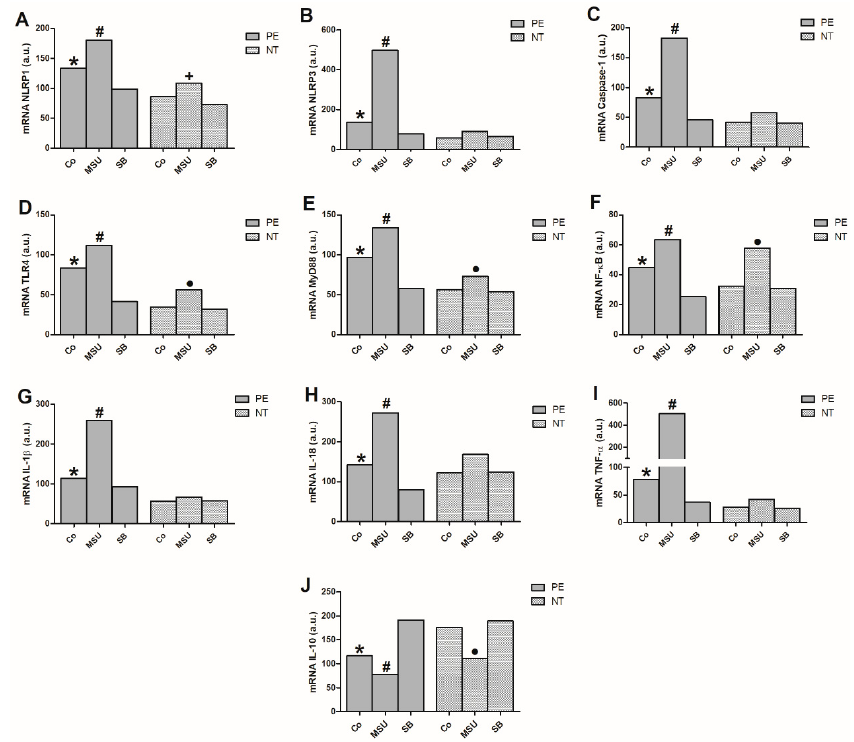
Figure 1. Gene expression of NLRP1 ( A ), NLRP3 ( B ), Caspase-1 ( C ), TLR4 ( D ), MyD88 ( E ), NF- κ B ( F ), IL-1 β ( G ), IL-18 ( H ), TNF- α ( I ) and IL-10 ( J ) in monocytes from 20 pregnant women with preeclampsia (PE) and 20 NT pregnant women, cultured in the absence (Co) or presence of MSU or SB. Results are expressed as the median in arbitrary units (a.u.). * p < 0.05 vs. NT Co, PE SB; # p < 0.05 vs. PE Co, PE SB; + p < 0.05 vs. NT SB; • p < 0.05 vs. NT Co, NT SB (Kruskal-Wallis